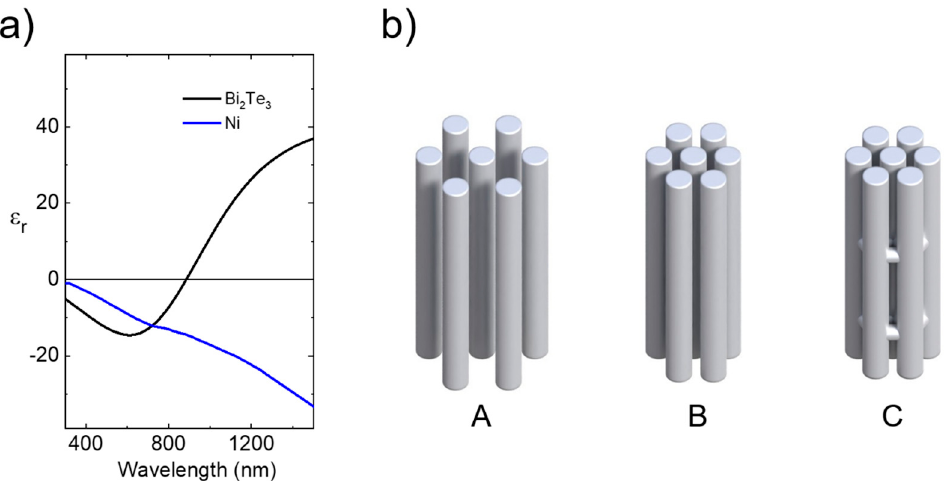
Figure 1. ( a ) Spectral dependence of the real part of ε // ( Bi 2 Te 3 ) and that of Ni, experimentally obtained in this work; ( b ) schemes of the different nanowire arrays, being A : 1D with a larger inter- wire distance, B : 1D with a shorter inter-wire distance, and C : 3D with inter-wire connections and the same inter-wire distance as B.